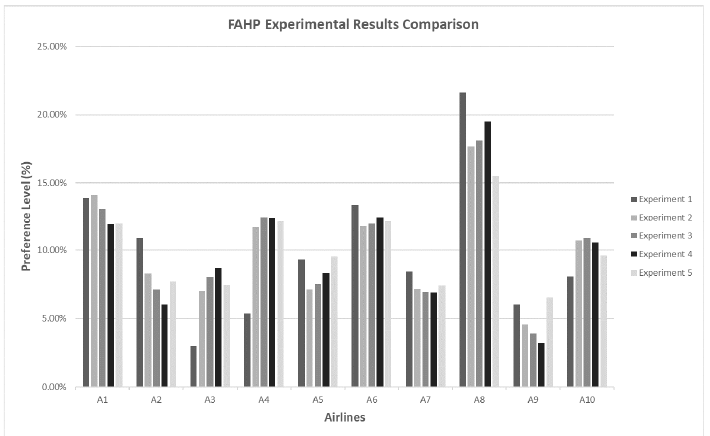
Fig. 1. FAHP experimental